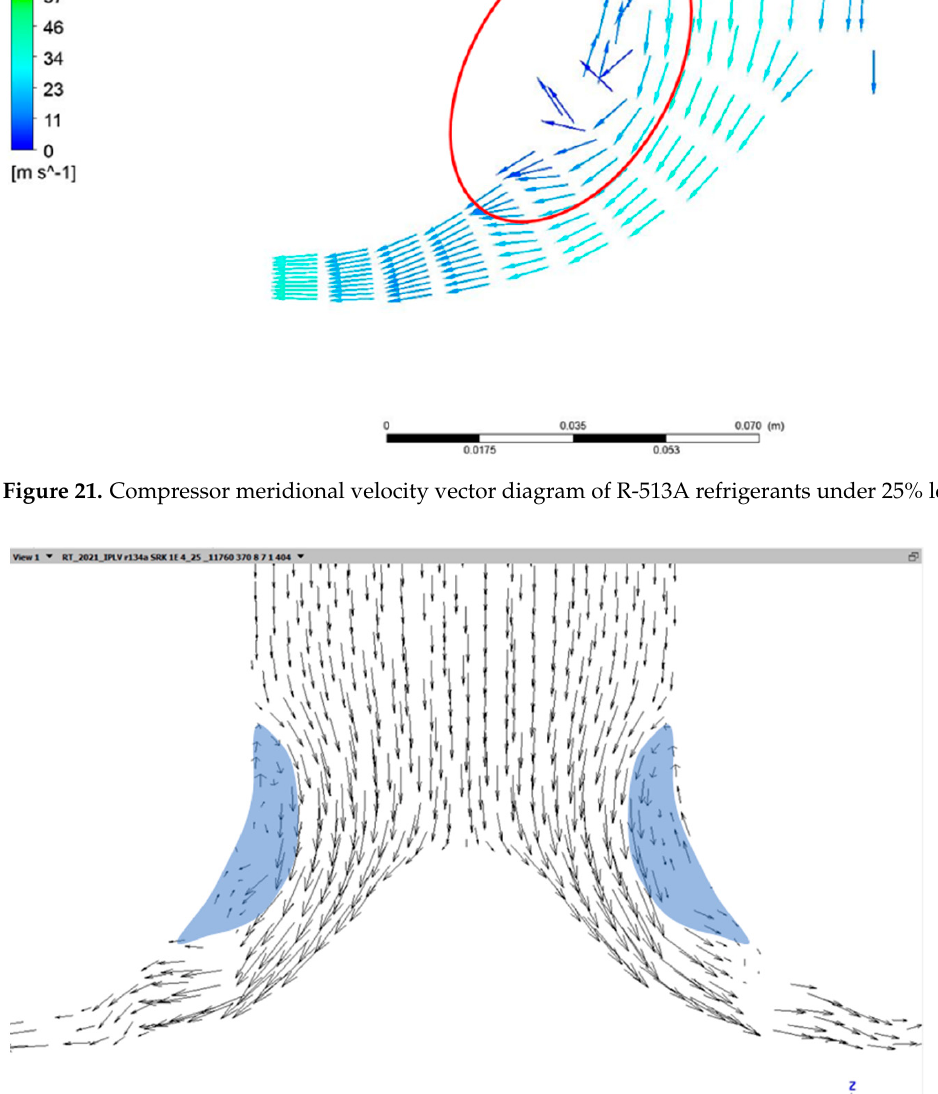
Figure 22. Compressor impeller velocity vector diagram of R-134a refrigerants under 25% load.